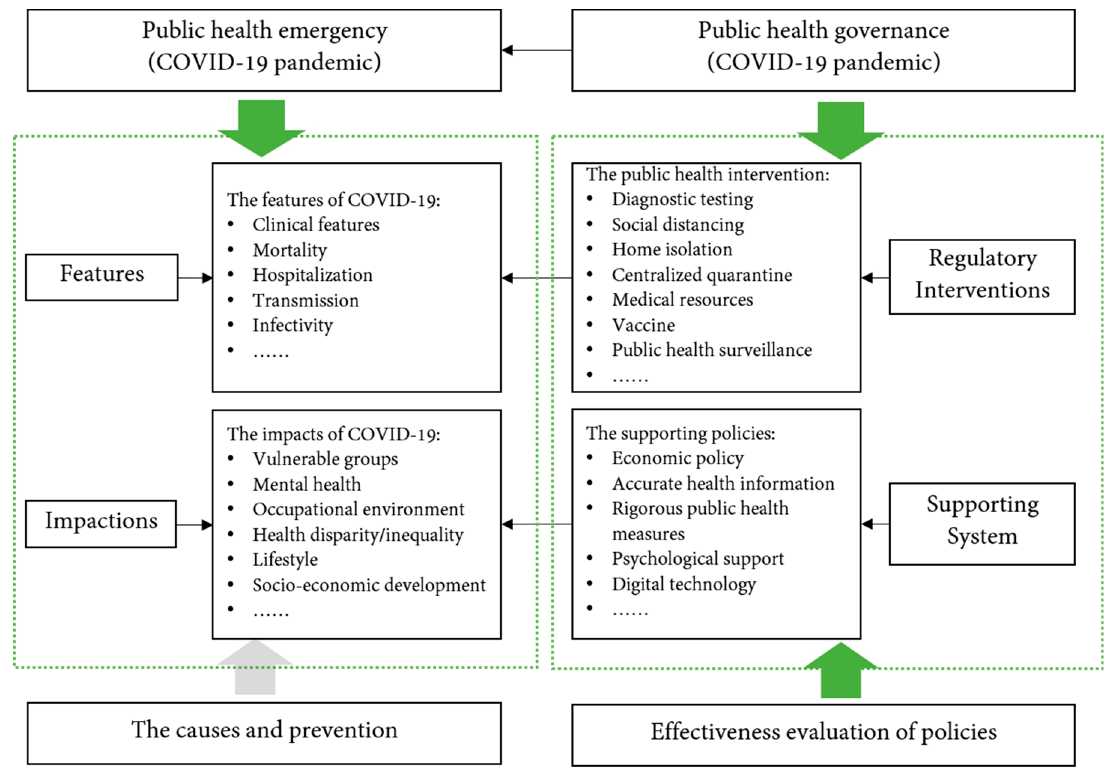
Figure 10. An analytical framework for research on public health governance during the COVID-19